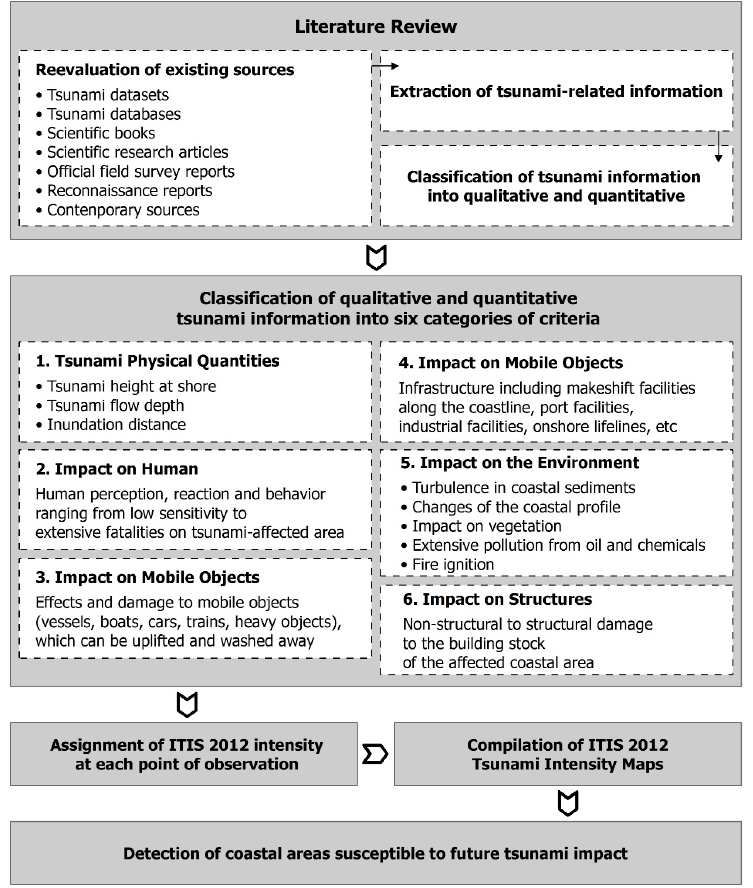
Figure 3. Flowchart for the detection of areas susceptible to future tsunami impact based on the results of the application of ITIS-2012 for historical and recent earthquake-triggered tsunamis.